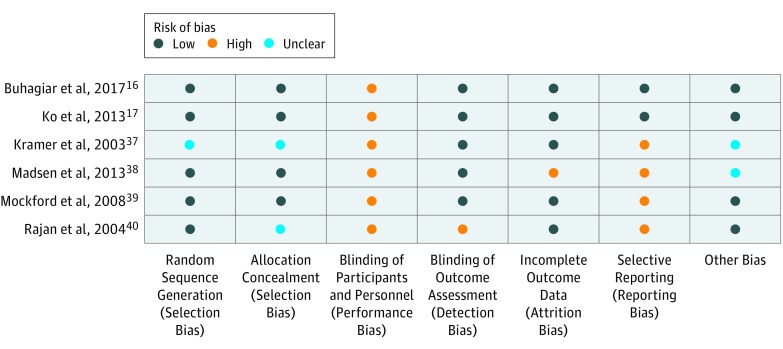
Cochrane Risk of Bias TableStudy quality was assessed using the Cochrane Collaboration Risk of Bias Tool.30